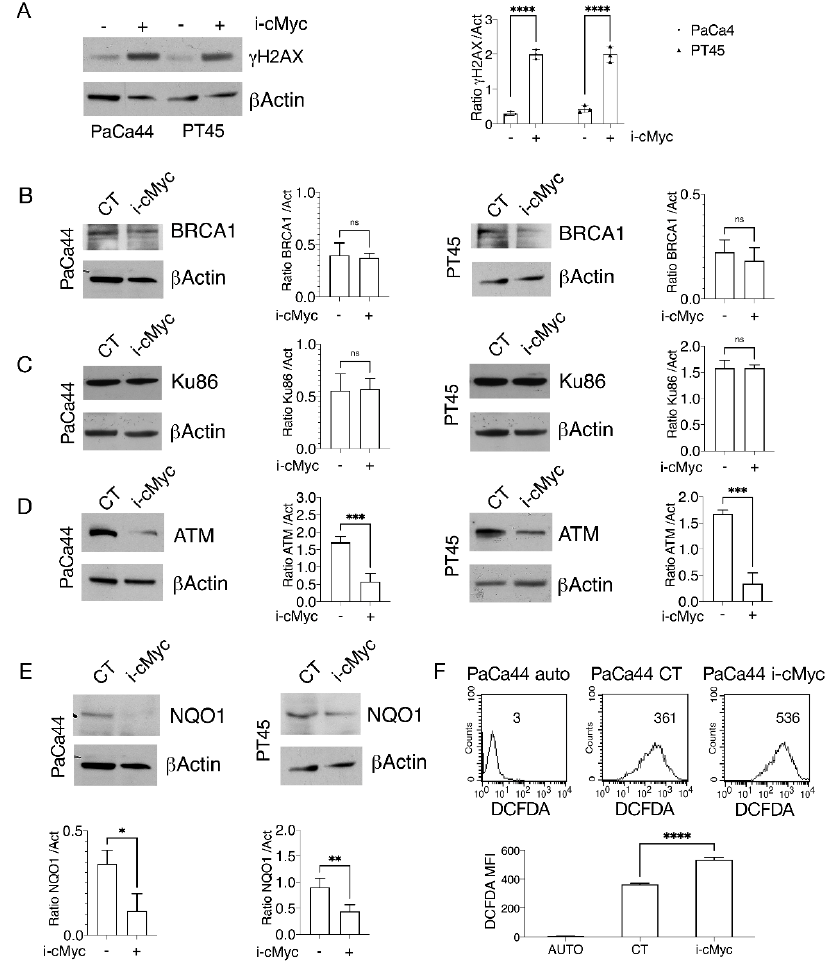
Figure 3. c-Myc inhibition increases DNA damage in pancreatic cancer cells. PaCa44 and PT45 cells were treated with cMyc inhibitor (i-cMyc) (50 µ M) for 48 h. ( A ) DNA damage was evaluated studying the phosphorylation of histone H2AX ( γ H2AX). β Actin was used as loading control and one representative experiment is shown. The histograms represent the mean ± SD of densitometric analysis of the ratio of γ H2AX /Act. p value: **** <0.0001. ( B ) BRCA1, ( C ) Ku86 and ( D ) ATM expression were evaluated by Western blot analyses. βActin was used as loading control and one representative experiment is shown. The histograms represent the mean ± SD of densitometric analysis of the ratio of BRCA1 /Act, Ku86/Act and ATM/Act. p value *** <0.001; ns = not significant. ( E ) NQO1 expression was evaluated by Western blot analyses. βActin was used as loading control and one representative experiment is shown. The histograms represent the mean ± SD of densitometric analysis of the ratio of NQO1/Act. p value * <0.05; ** <0.01; ( F ) Intracellular ROS level was measured by FACS analysis using DCFDA as staining. Mean of fluorescence intensity (MFI) is indicated. One representative experiment out of three is reported. Auto means autofluorescence of unstained control cells; The bars in the histogram represent the means of MFI of three independent experiments. p -value: **** <0.0001.